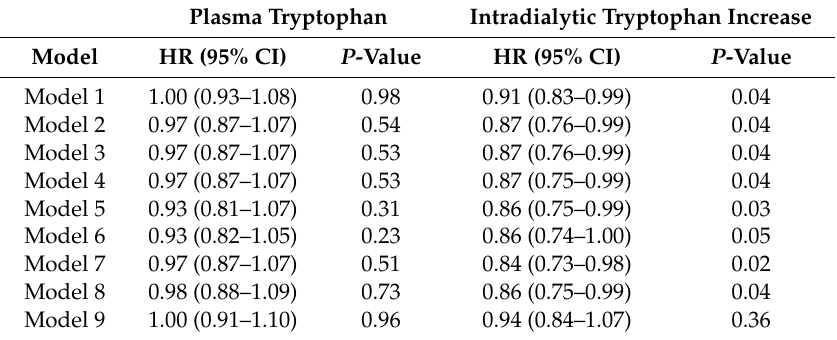
Table 5. Cox regression analyses of plasma tryptophan and intradialytic plasma tryptophan increase. Plasma Tryptophan Intradialytic Tryptophan